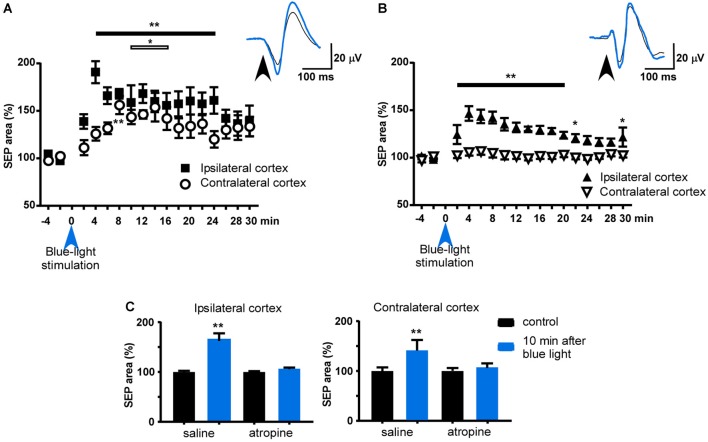
Effect of blue-light stimulation of HDB and B nuclei on ipsi- and contralateral S1 cortices. (A) Plot of the somatosensory evoked potential (SEP) area during the control period (4 min before blue-light stimulation) and 30 min after blue light stimulation of HDB. The mean area of the control period was considered as 100%. HDB induced a facilitation of both SEP recorded in both hemispheres, although the area increased slower in the contralateral cortex to the stimulated HDB. (B) Same plot as in (A) after blue light stimulation of B nucleus. Note that contralateral SEP area was not affected. (C) Plots of the effect of atropine sulfate on HDB stimulation. The effect was measured 10 min after HDB stimulation respect to the mean SEP area during the control period (4 min before blue light stimulation). After saline i.p. injection blue-light stimulation induced a facilitation of SEP area in both ipsi- and contralateral cortices (n = 8). However, the effect was blocked when atropine was i.p. injected 10 min before HDB stimulation. Insets in (A,B) show representative traces of the SEP in control and 10 min after optogenetic stimulation (black and blue tracers, respectively). *p < 0.05; **p < 0.01.